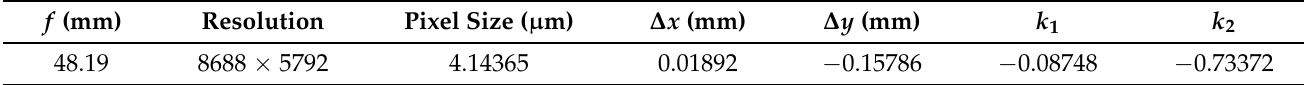
Table 1. Camera parameters of first experiment.